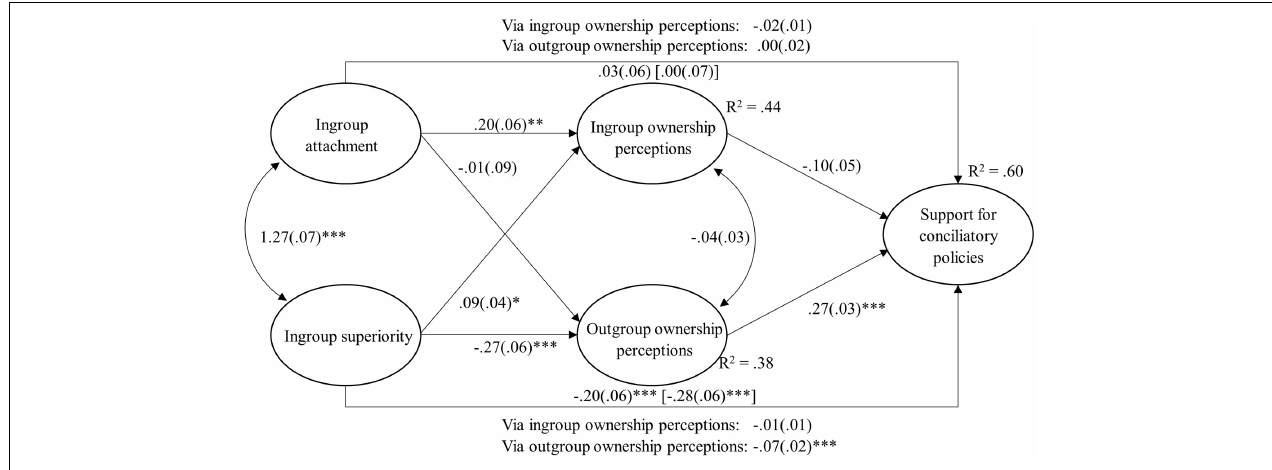
FIGURE 1 | Unstandardized results of a structural equation model explaining support for conciliatory policies ( N = 1,268). Total effect shown in square brackets; R 2 is the explained variance of the latent outcome variables; ∗ p < 0.05, ∗∗ p < 0.01, ∗∗∗ p < 0.001. Model fit: [ χ 2 (df) = 1090.46 (261) ∗∗∗ , CFI = 0.935, SRMR = 0.042, RMSEA (90% CI) = 0.050, (0.047, 0.053)]. For results of the control variables (see Table 3 ).